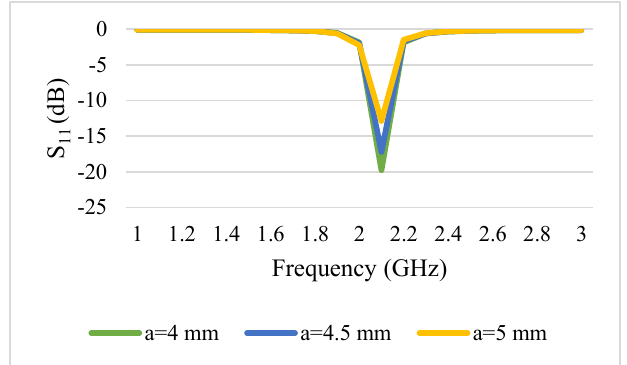
Fig.1.6 Polygon shaped patch Antenna 2-Topology